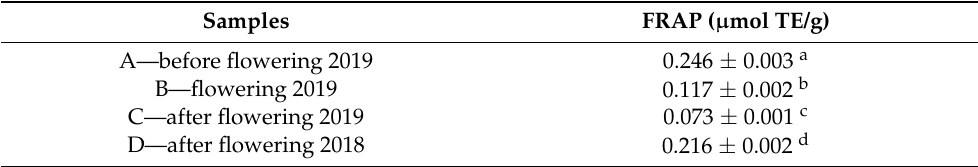
Figure 5. The graphs of precipitation: ( a ) 2018 [42], ( b ) 2019 [43]. Table 4. Antioxidant capacity of hemp